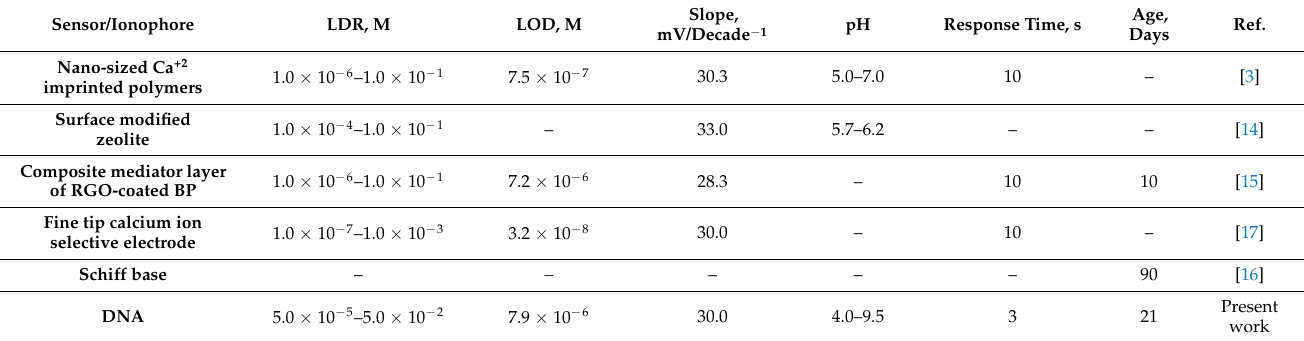
Table 4. Comparison of the present sensor with previously recorded Ca +2